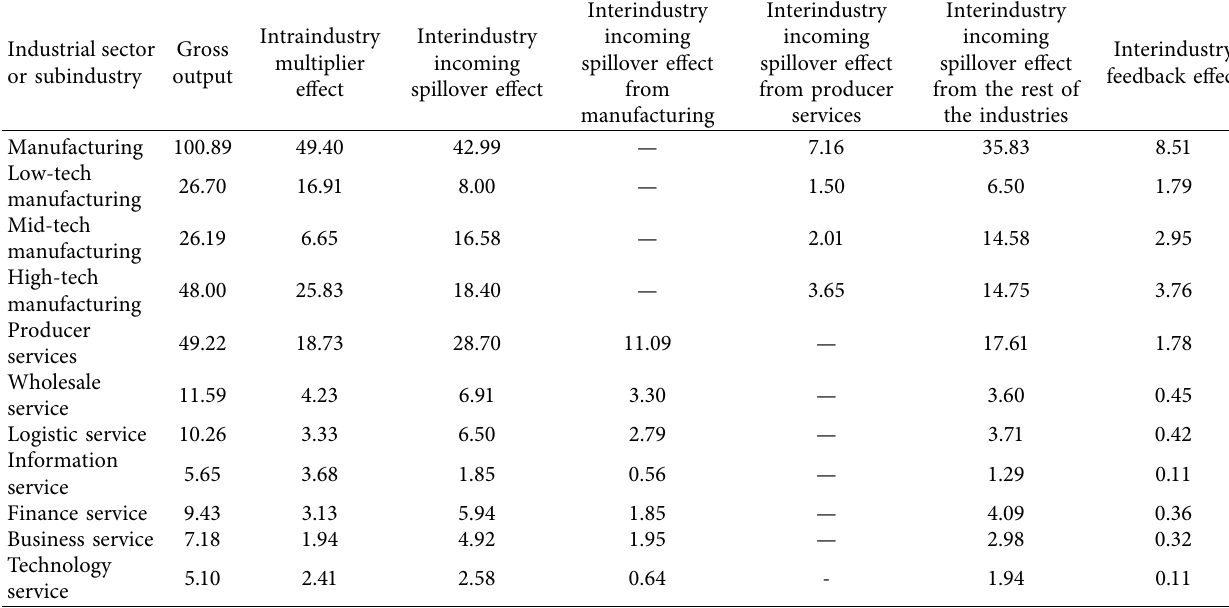
Table 3: Decomposition components of gross output of manufacturing, producer services, and their subindustries.